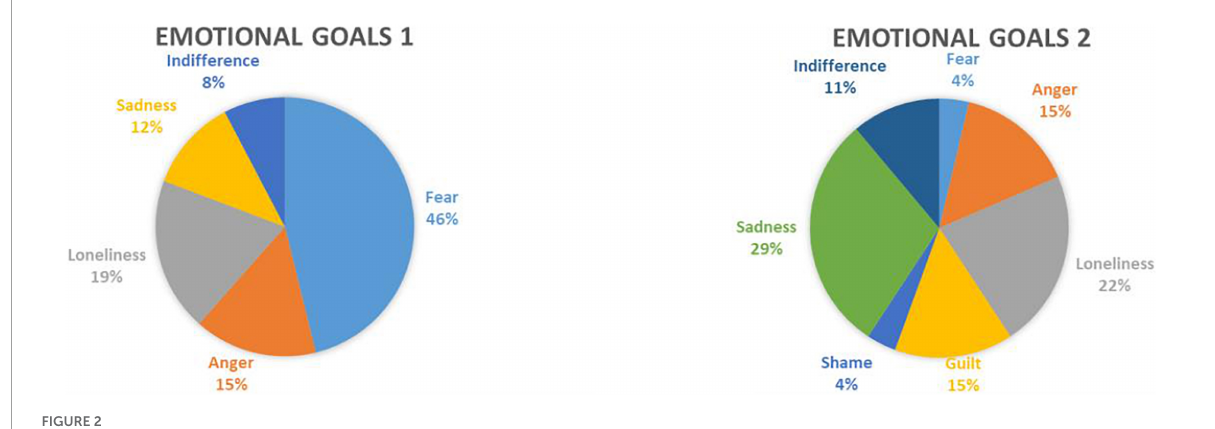
change between post-assessment and FU-assessment time points was